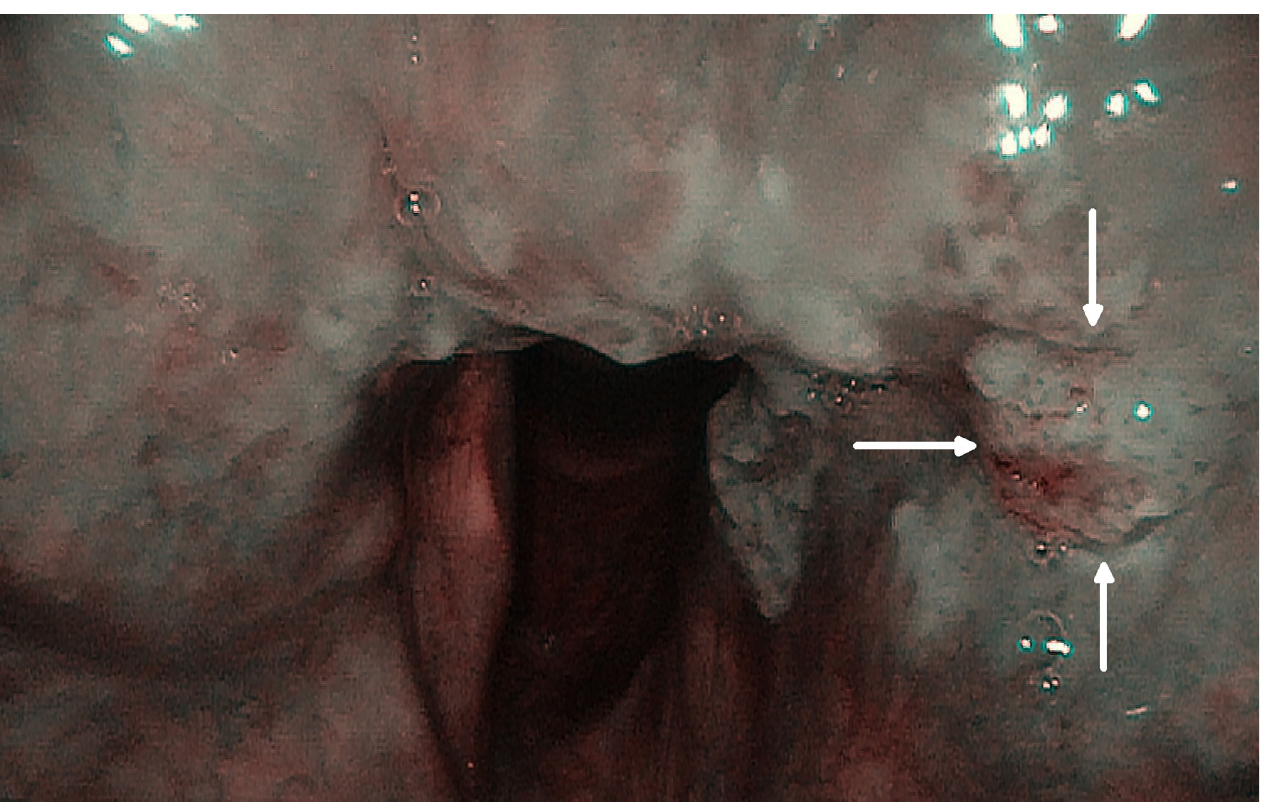
Fig 3. Mucosa with suspicious vascular pattern in NBI. Arrows indicate areas of